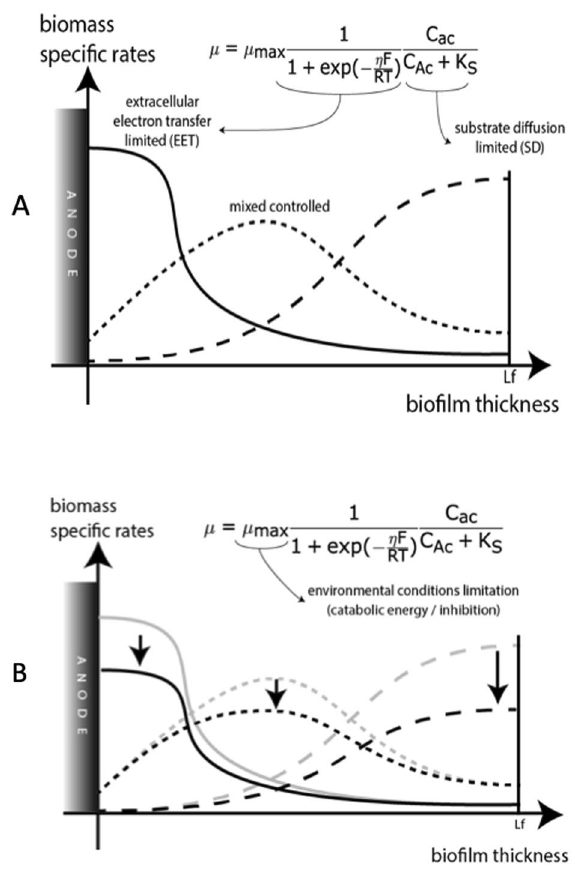
Figure 2. Limiting factors in the biomass specific rate inside the biofilm. ( A ) Substrate diffusion and electron transfer limitation; ( B ) Environmental conditions